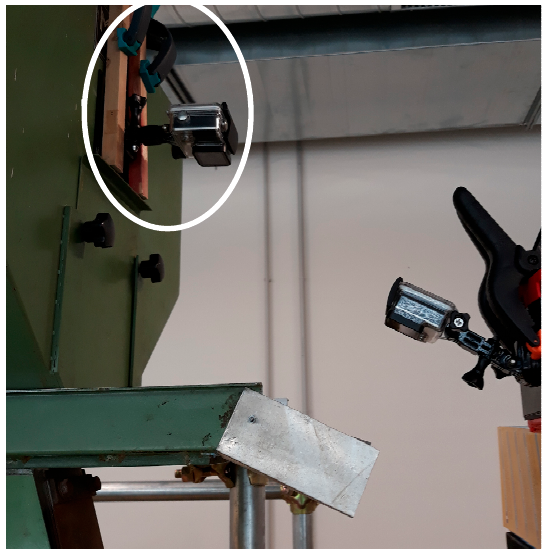
Figure 5. Camera shooting the vibrating channel from the top. Another camera is depicted that shoots a sediment slide; this second camera was used in an additional method that was later abandoned and is not described in this paper.